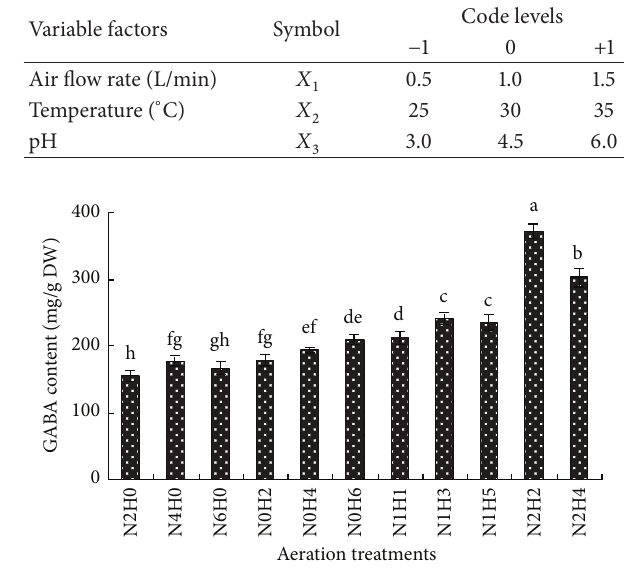
Figure 1: GABA accumulation in germinated tartary buckwheat under different aeration treatments. ∗ N indicates normal dark culture with distilled water at 30 ∘ C; H denotes aeration stress with 1.0 L/min air flow rate at 30 ∘ C. Therefore, N0H2 denotes normal culture at 0d and then stress at 2 d, where N2H2 represents normal culture at 2 d and then stress at